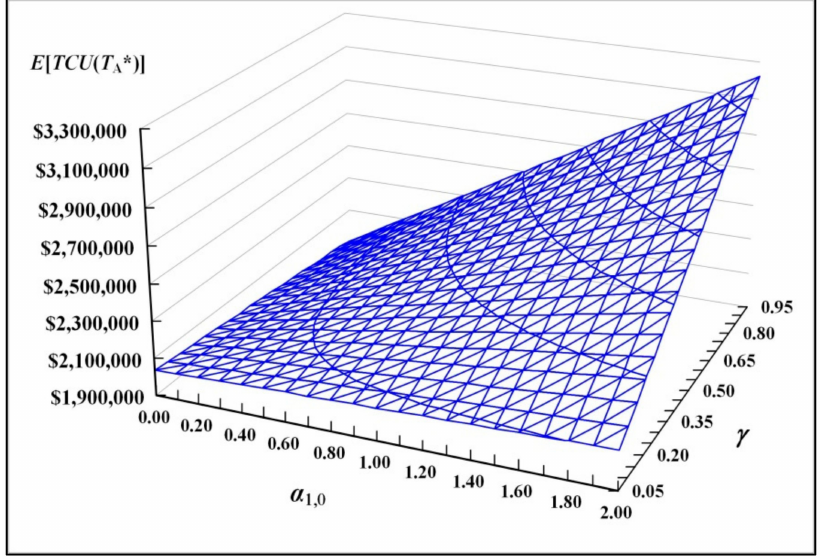
Figure 14. The collective impact of di ff erences in α 1,0 and γ on E [ TCU ( T A